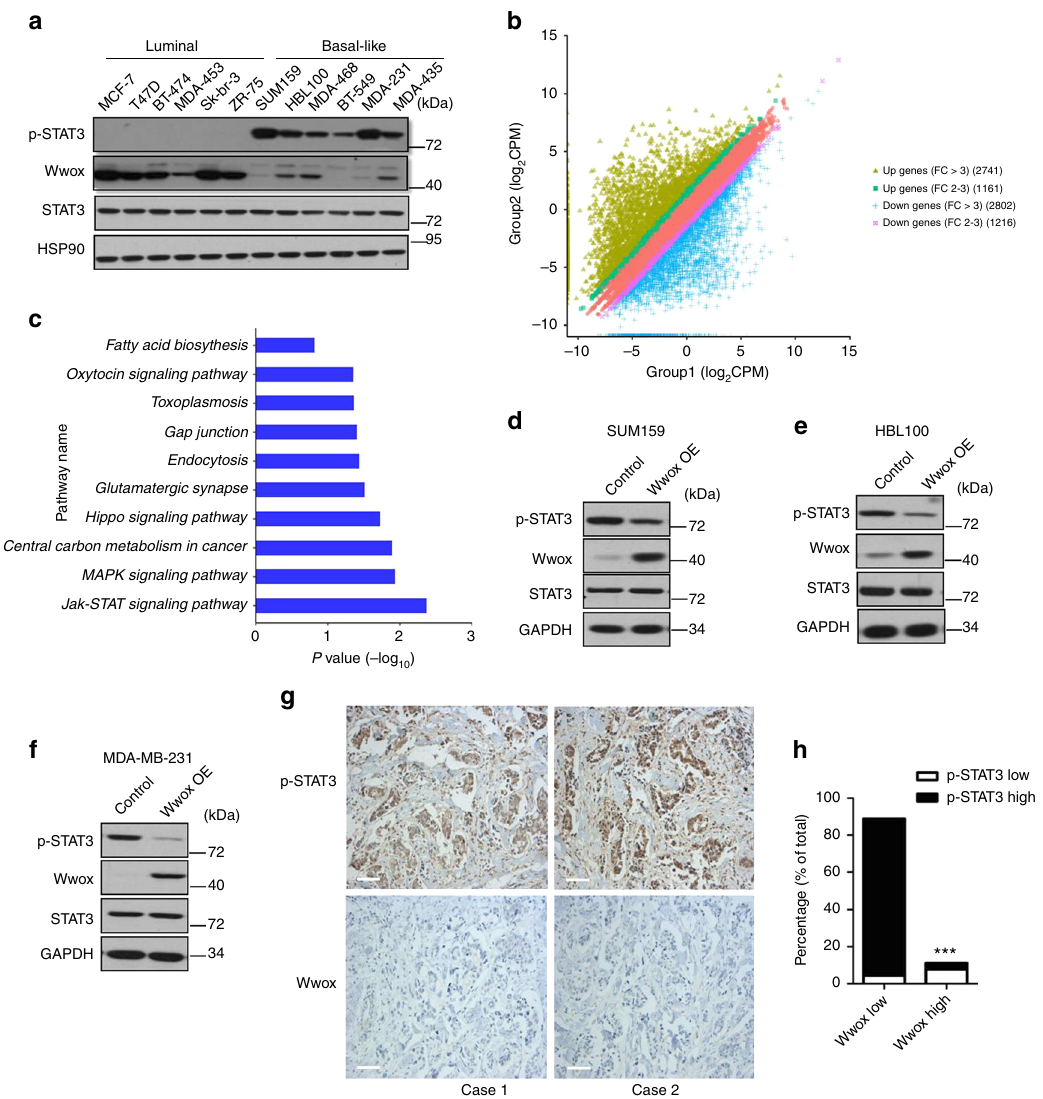
Fig. 1 Wwox and p-STAT3 exhibit converse patterns of expression in breast cancer (BC) cells. a Western blotting was performed to detect p-STAT3 and Wwox levels in 12 human BC cell lines. The protein levels of p-STAT3 were detected. b 2D plots of total RNA-seq genes in Group 1 luminal cells (MCF-7, T47D, BT-474) and Group 2 basal cells (SUM159, HBL100, BT-549). Up- and downregulated genes with fold change ≥ 2.0 are highlighted. c KEGG pathway analysis of up-regulated genes in basal cells compared with luminal cells. d – f Western blot analysis of Wwox and p-STAT3 expression in SUM159 ( d ), HBL100 ( e ), and MDA-MB-231 cells ( f ) stably transfected with control (CT) or Wwox-encoding vectors. g , h IHC determination of Wwox and p-STAT3 expression in 90 human triple-negative BCs. Representative IHC staining images of Wwox and p-STAT3 ( g ); results are tabulated as shown ( h ); *** p < 0.001, χ 2 test, scale bar, 100 μ